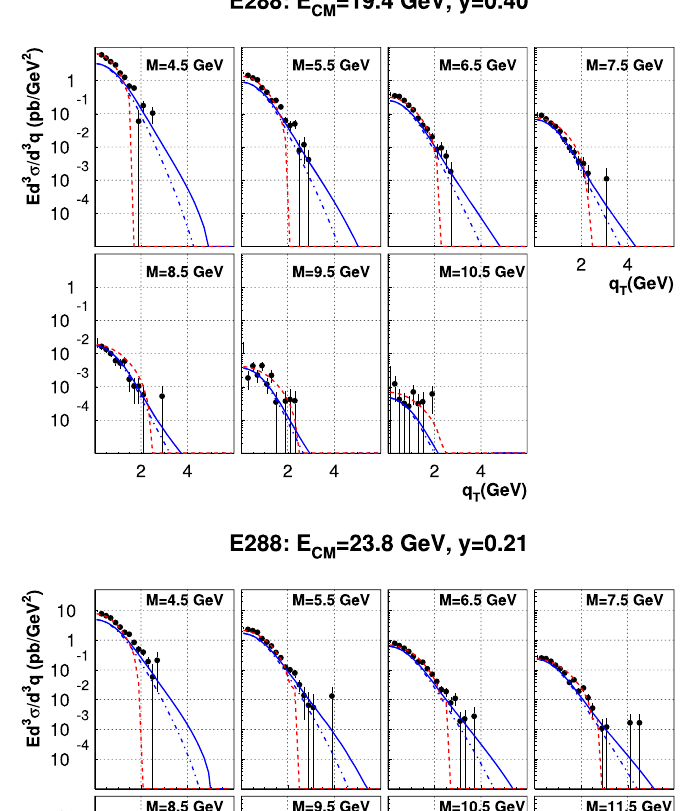
Fig. 5 Transverse momentum dependence of DY cross section: data from fixed target experiment E288 [38] are compared with on-shell CCFM-K (blue solid), off-shell CCFM-K (blue dash-dotted) and CSS (red dashed)